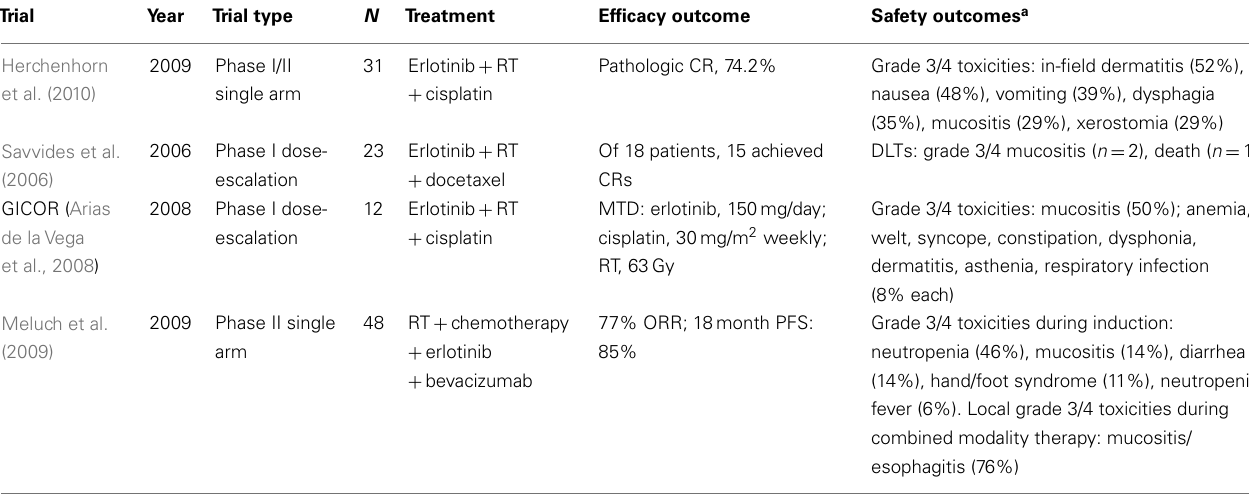
Table 1 | Recent trials of erlotinib and radiotherapy in head and neck squamous cell